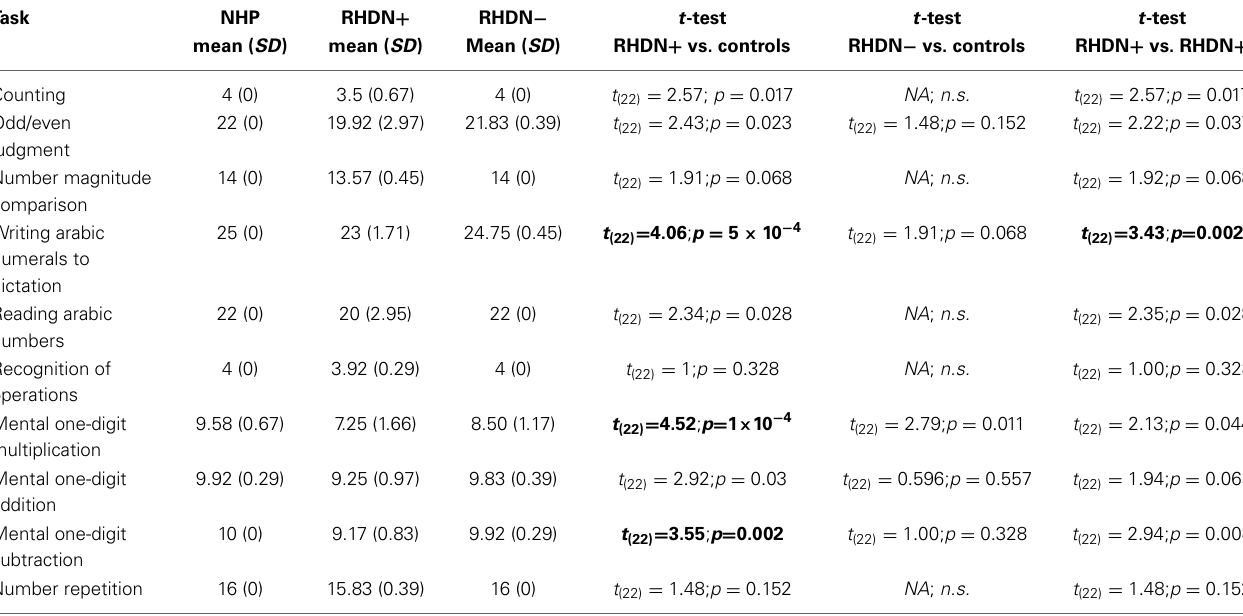
Table 3 | Mean and statistical tests comparing patients and healthy controls in the different sub-tests of the Numerical